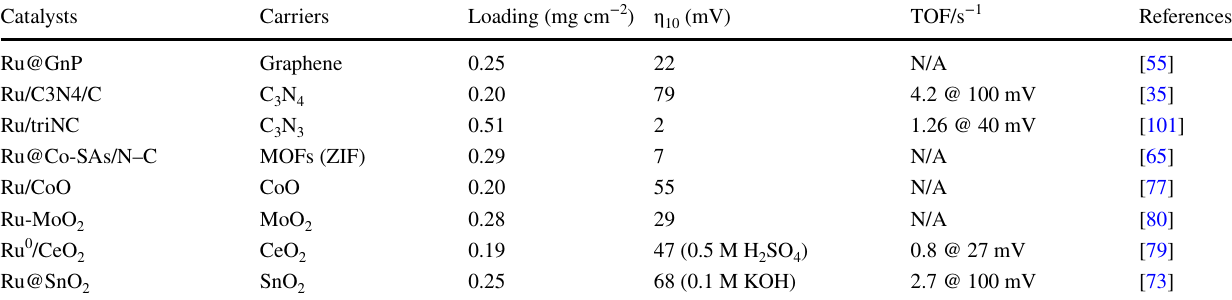
Table 3 HER performance under different supports at 1.0 M KOH Catalysts